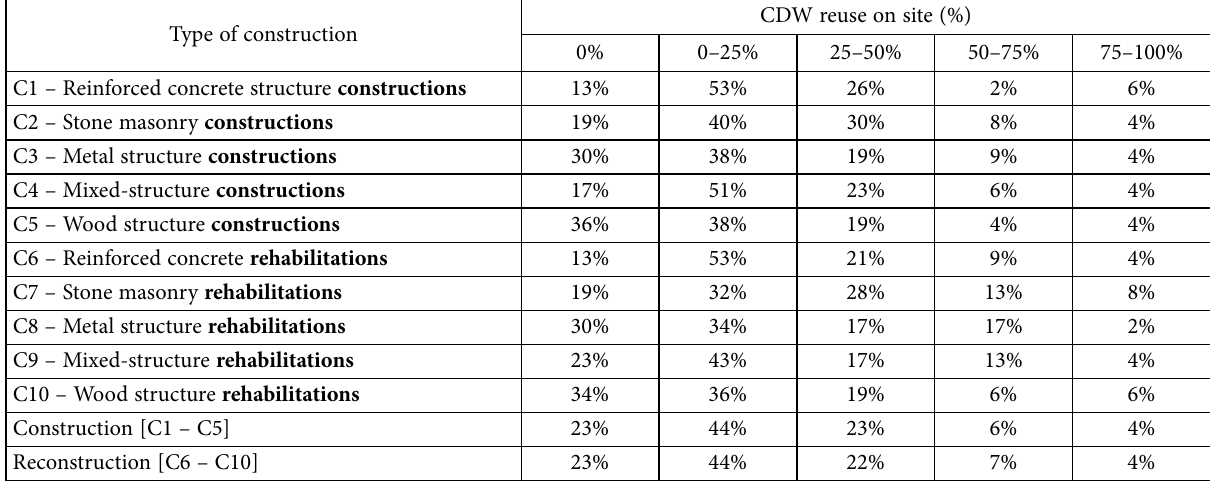
Table 7. Distribution of CDW reuse by type of construction ( n = 153) Type of construction